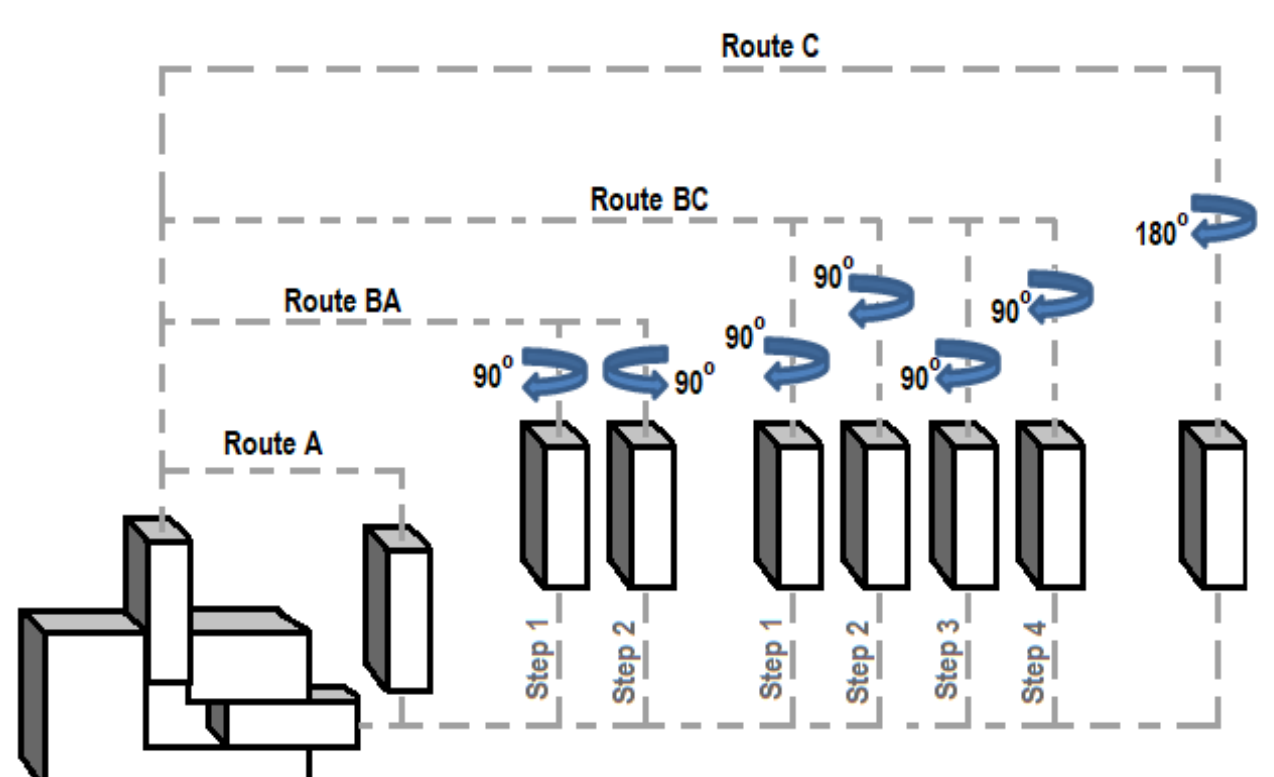
Figure 1. Routes creating various changes in the material during ECAP extrusion.